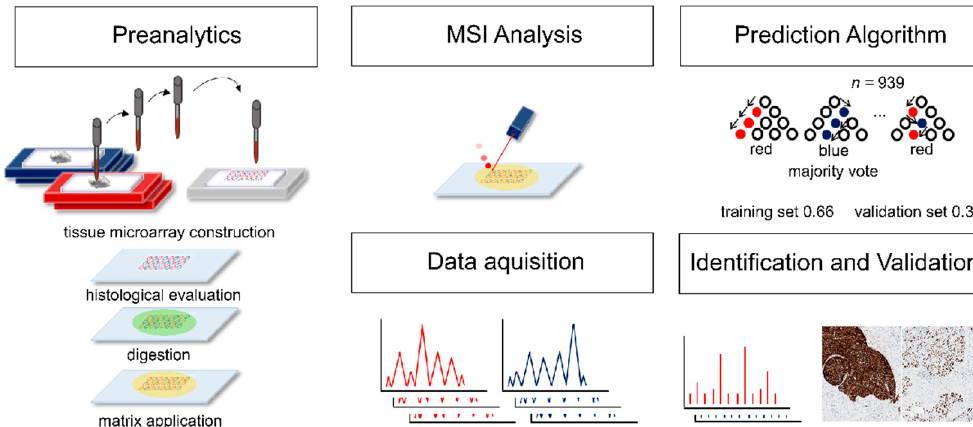
Figure 4. Workflow of mass spectrometry imaging analysis and data evaluation. Tissue microarrays were constructed and analyzed by mass spectrometry imaging. Samples were randomly assigned to a training set (66% of samples) and a test set (33% of samples). A prediction algorithm was created on the training set and validated on the test set. After data evaluation, the most important m/z values were identified by tandem mass spectrometry and validated using immunohistochemistry.